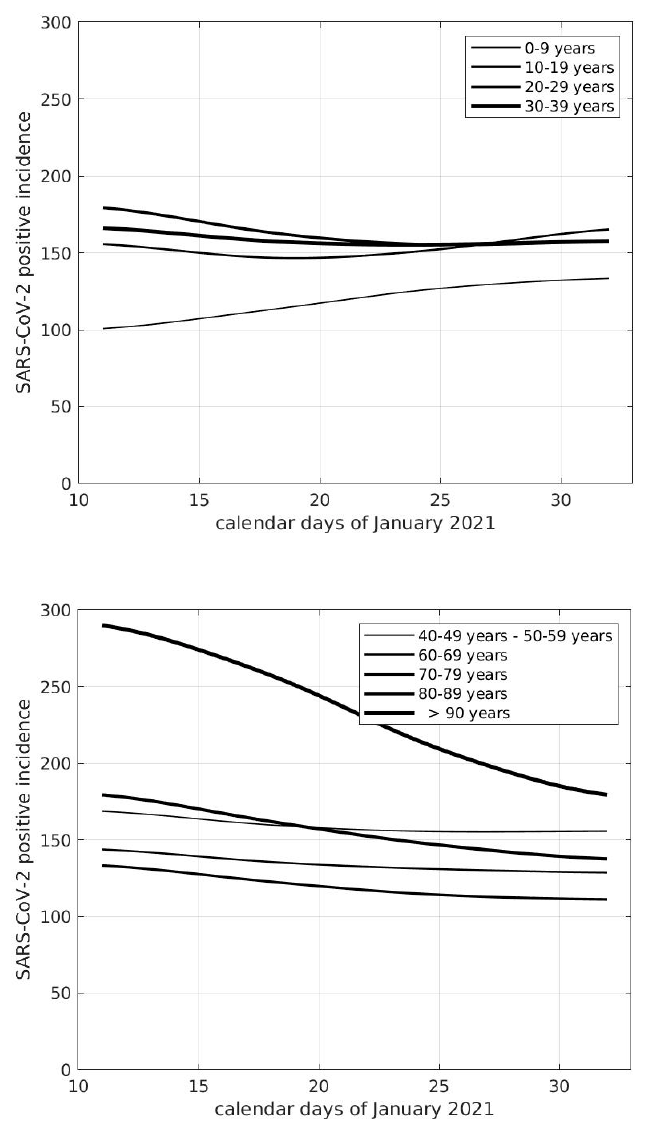
Figure 2. Curves of SARS-CoV-2 incidence in Italy referred to one week and 100,000 inhabitants of different age groups.